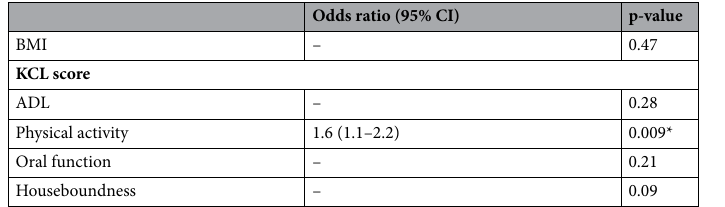
Table 4. Multiple logistic regression analysis of risk factors at the baseline for transition towards frailty. BMI body mass index, KCL Kihon Checklist, ADL activity of daily living, CI confidence interval. *p <